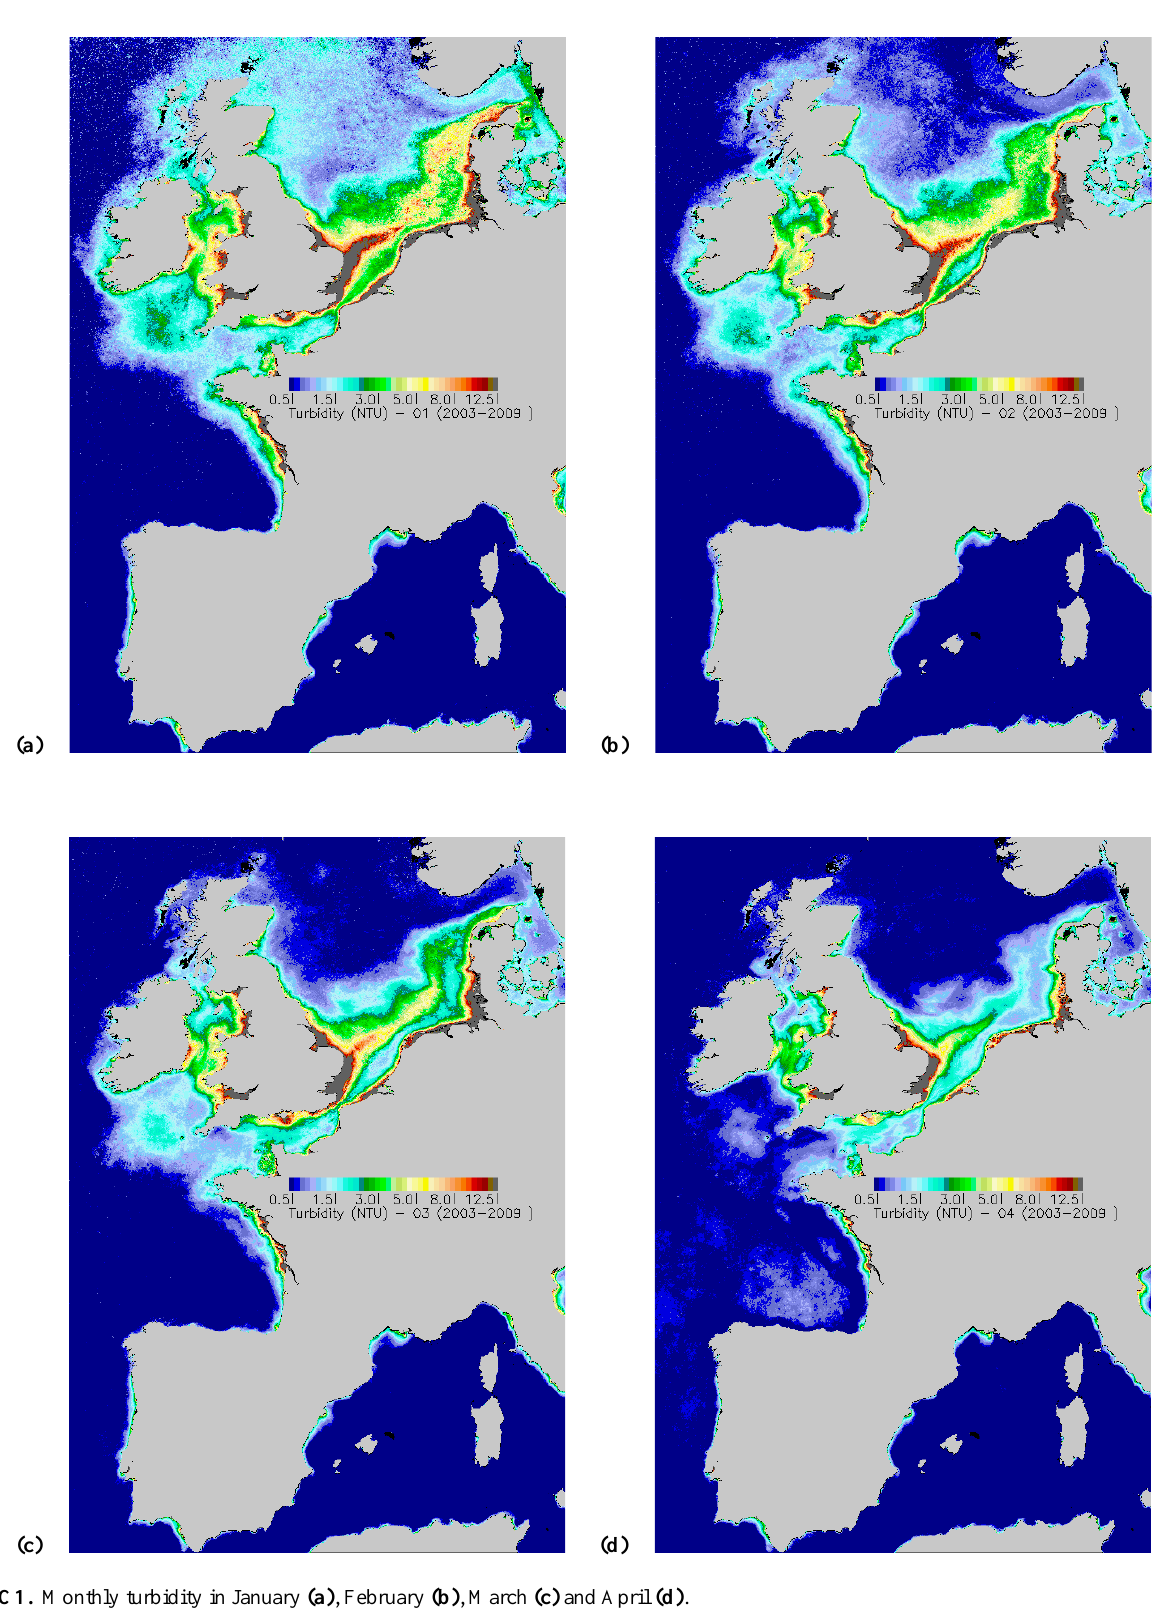
Fig. C1. Monthly turbidity in January (a) , February (b) , March (c) and April (d)